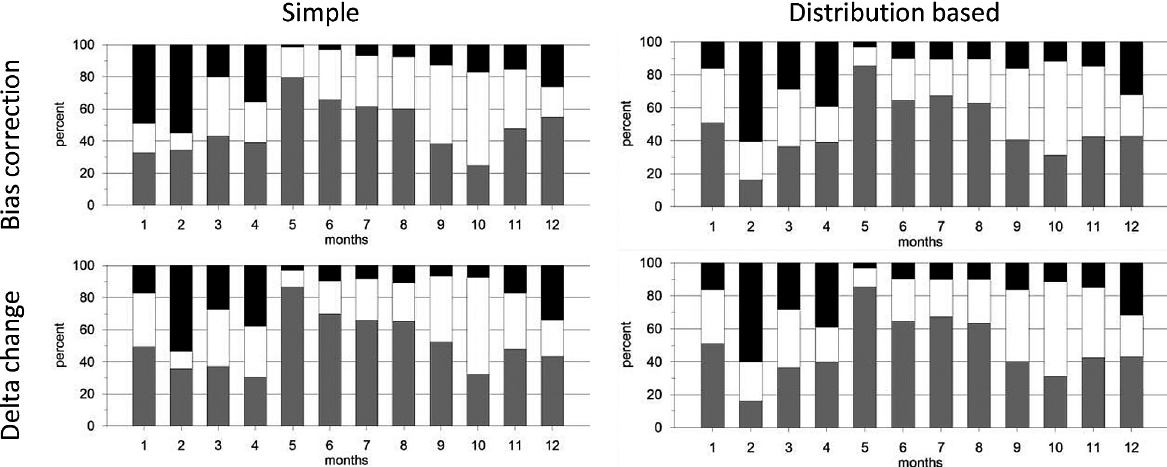
Fig. 6. Frequencies of improvements (grey), no change (white) and worsening (black) after corrections made by different methods for 90th percentile. Bias correction methods in the upper raw and delta change methods in the lower raw, simple variants in the left column and distribution based variants in the right